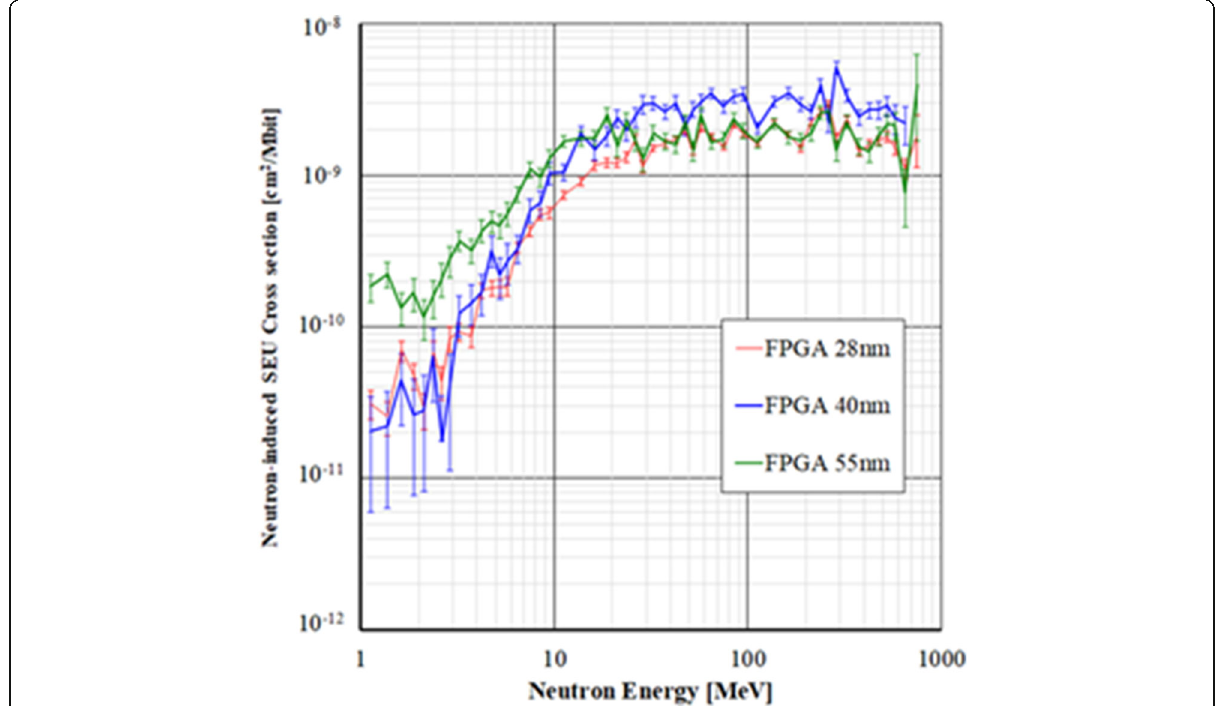
Fig. 14 Neutron-induced SEU cross sections